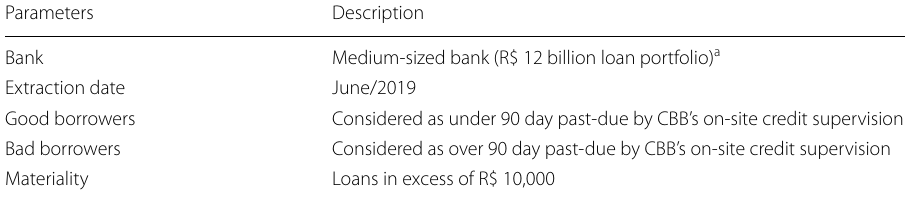
Table 5 Parameters and criteria adopted to classify borrowers in the real bank